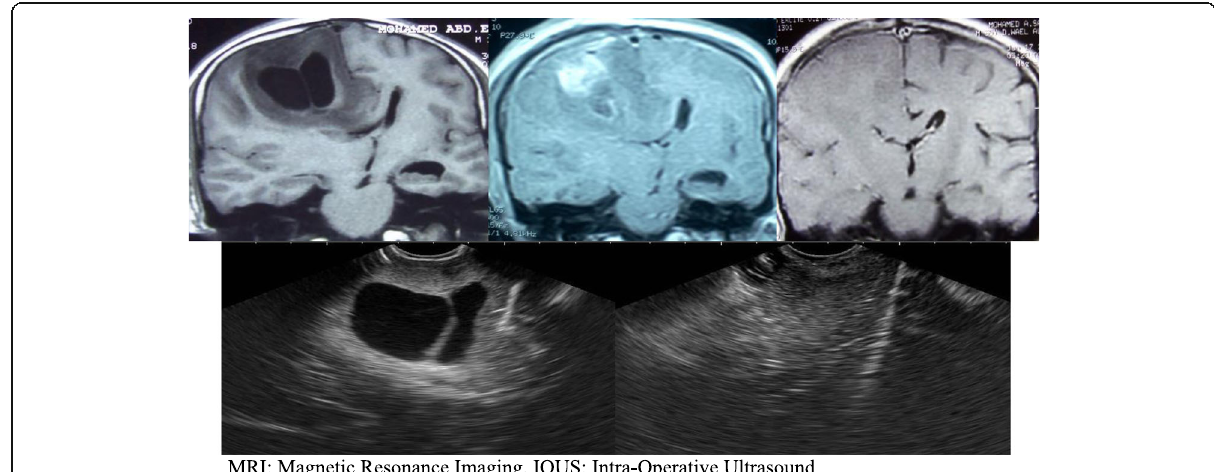
Fig. 5 Gross total resection of pleomorphic xanthoastrocytoma grade 2, preoperative and postoperative ( early and after 3 months ) MRI T1 with contrast and IOUS images